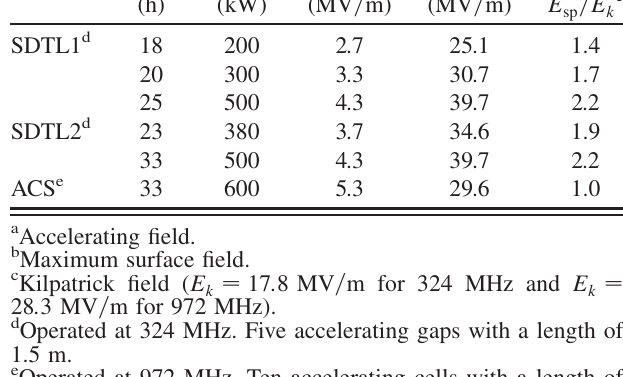
FIG. 13. Resonant frequency as a function of the adjustable plunger positions (the three plungers are moved